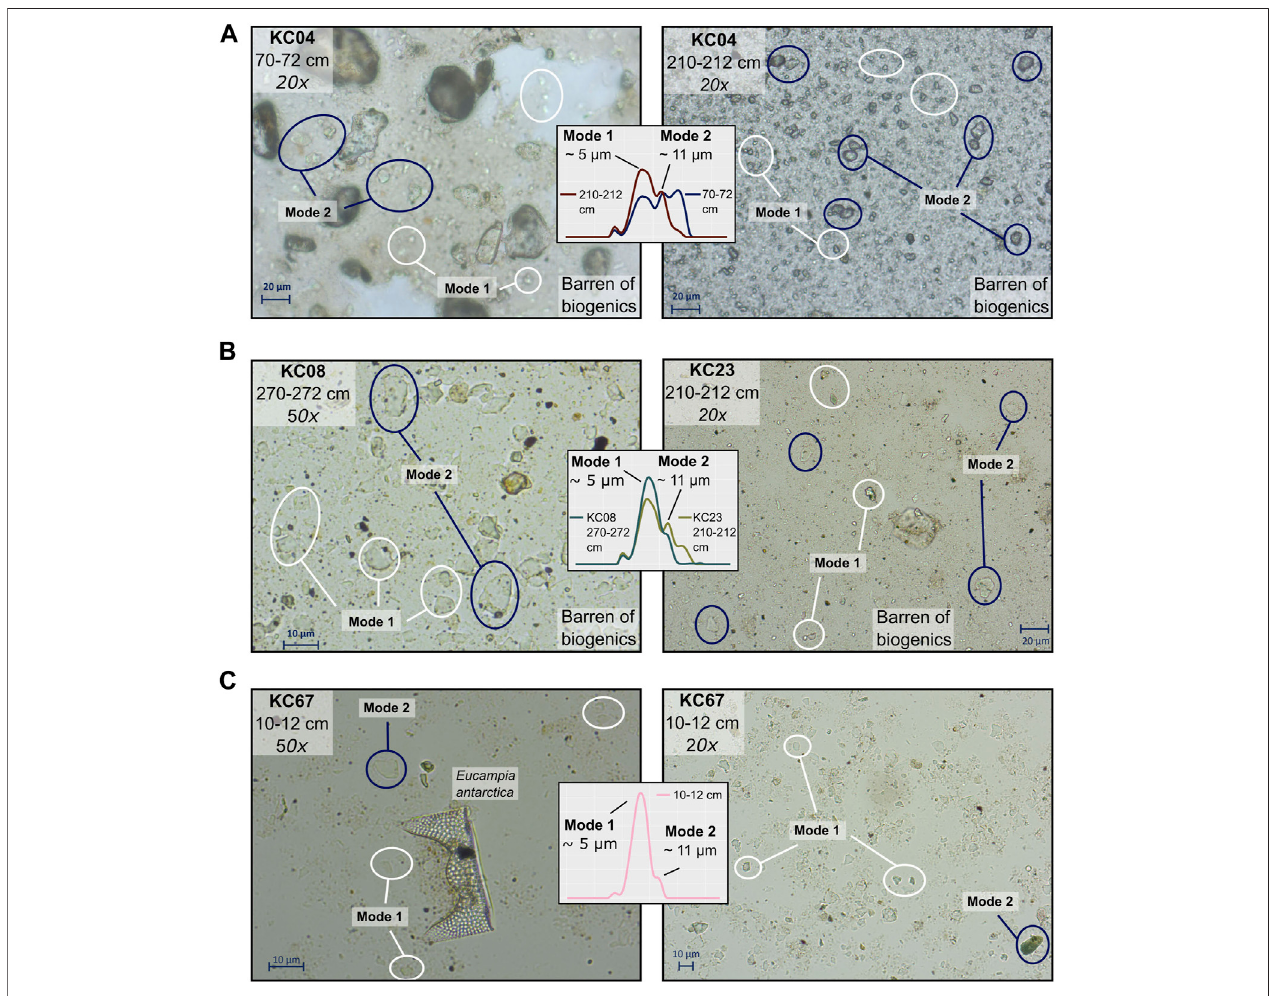
FIGURE 3 | Smear slide images and corresponding grain-size distributions for select samples. Images were taken under plane-polarized light. Grain-size distributionsshownforcorresponding intervalshavethesameaxislabelsasin Figure2B .Panelsexaminegrain-sizeModesoneandtwoinintervals (A) withinthesame core, (B) from cores from different geographic locations, and (C) in surface sediments. (A) Core KC04 is dominated by poorly-sorted, ice-shelf proximal sediments (left) but contains discrete layers of purely terrigenous and relatively well-sorted fi ne silt (right). (B) KC08 (left; offshore from TGT) and KC23 (right; EIS corner).Grain size modes one and two are caused by terrigenous grains that are present in variable amounts despite geographical difference between sites. (C) KC67 is dominated by Mode-1 grains and features sparse, complete diatom frustules.